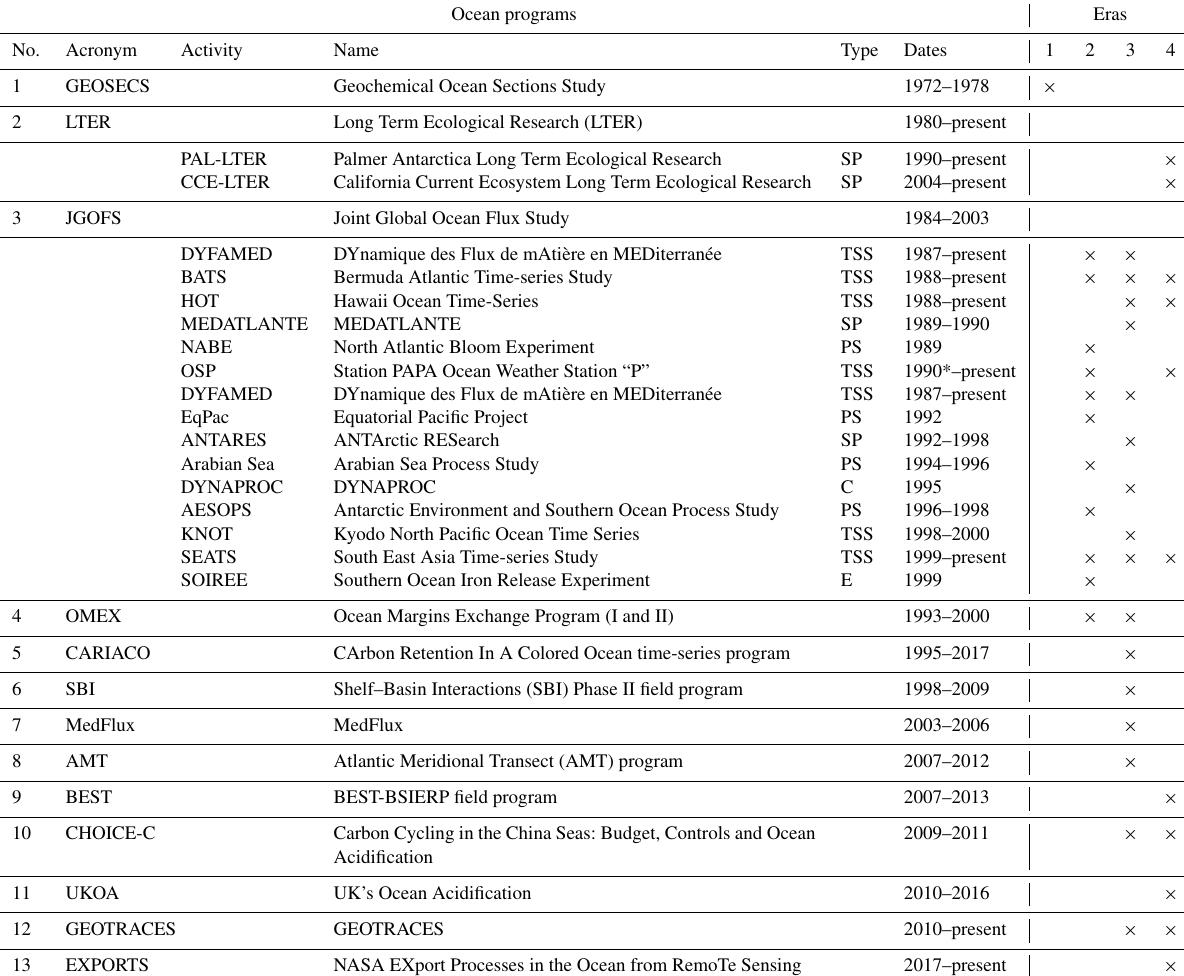
Table 2. Selected ocean programs from the 50 years of 234 Th data compiled and significant activities within these programs with 234 Th samplings chronologically ordered. Activities are categorized as follows: (i) cruises (C), (ii) experiments (E), (iii) long-term time-series station (TSS), (iv) process study (PS), and (v) sub-program (SP). Programs and activities are detailed by era, as indicated with a cross.